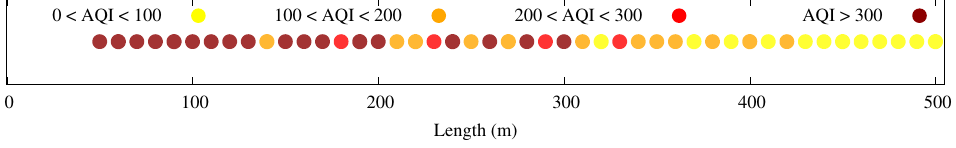
Figure 17. Risk estimation based on PM10